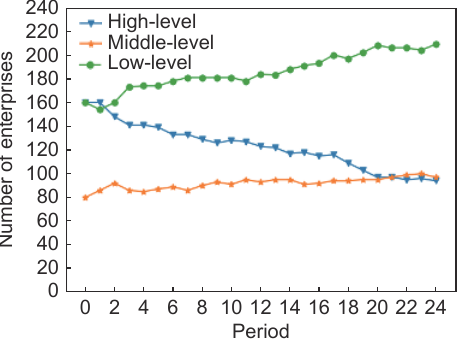
Fig. 1 Scene 1, number changes of low-, middle-, and high- level enterprises.